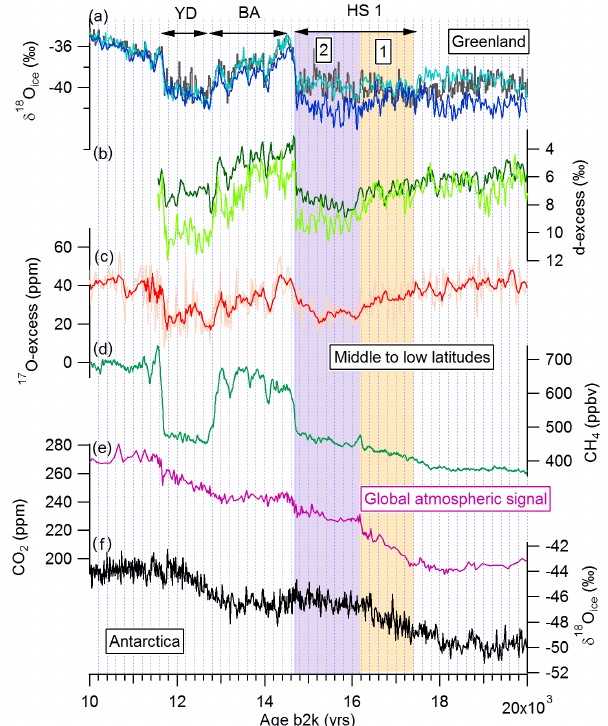
Figure 2. A synthesis of ice core records over the last deglaciation displayed on the respective GICC05 and AICC2012 timescales with an identification of two phases (1, orange box; 2, purple box) within Heinrich Stadial 1 (HS1) as discussed in the text: we locate the tran- sition between phases 1 and 2 at the timing of the sharp increase in CO 2 and CH 4 concentrations, both being global atmospheric composition signals. The Younger Dryas (YD) and Bølling–Allerød (BA) periods are also indicated. (a) GRIP, NGRIP, and GISP2 δ 18 O (light blue, dark blue, and black, respectively; Grootes et al., 1993; NGRIP community members, 2004) interpolated at a 20-year res- olution; (b) GRIP and NGRIP d-excess (light and dark green, re- spectively; Jouzel et al., 2005, this study) interpolated at a 20-year resolution; (c) NGRIP 17 O-excess (orange curve shows the origi- nal series and the red curve the 5-year running average; this study); (d) WAIS Divide CH 4 (Rhodes et al., 2015); (e) WAIS Divide CO 2 (Marcott et al., 2013); (f) EPICA Dronning Maud Land (EDML) δ 18 O ice (EPICA community members,